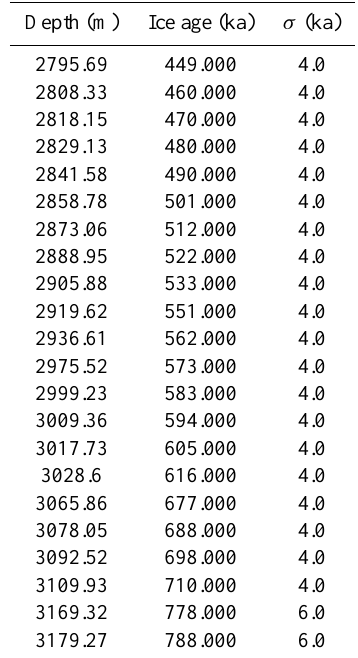
Table 3. Orbital ages from δ O 2 / N 2 for EDC, deduced from Landais et al.